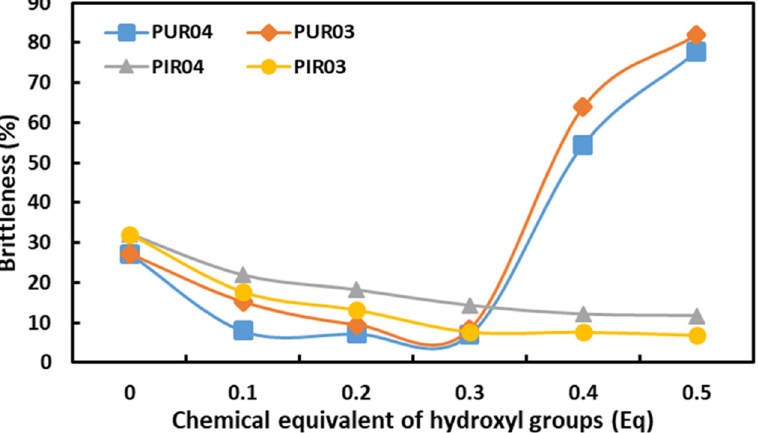
Figure 8. Dependence of brittleness on the content of eco-polyols based on PLA waste. The new eco-polyols had a significant impact on the brittleness of RPU and RPU/PIR foams. The increase in the content of eco-polyols in RPU foams to 0.3 Eq and in RPU/PIR foams to 0.5 Eq resulted in a significant reduction in this parameter in comparison with the reference foams. For example, the brittleness of Ref. PUR foam was 27.18%, while after applying 0.3 Eq of eco-polyols it was 7.04% for PUR04.3 (0.3 Eq of PLA0.4DEG eco-polyol) and 8.3% for PUR03.3 (0.3 Eq of PLA0.3DEG eco-polyol), respectively. A further increase